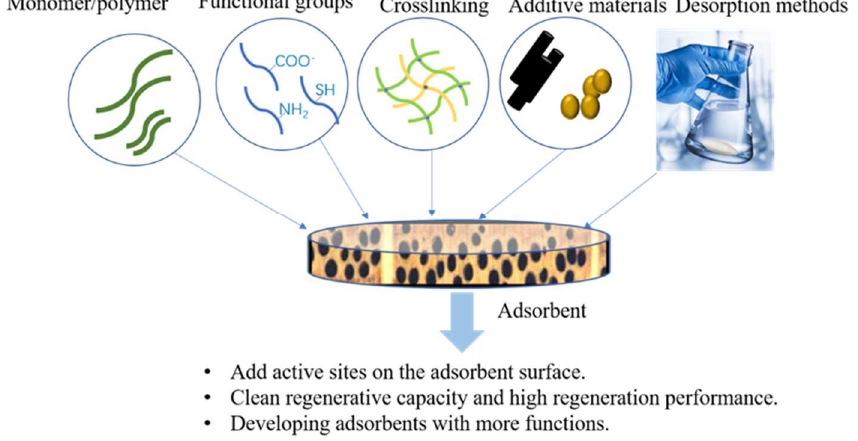
Figure 10. By regulating key elements, including monomers/polymers with different functional groups, and cross-linking types and desorption methods promote nanocellulose-based adsorbents with many advanced properties that excel in heavy ion removal applications.